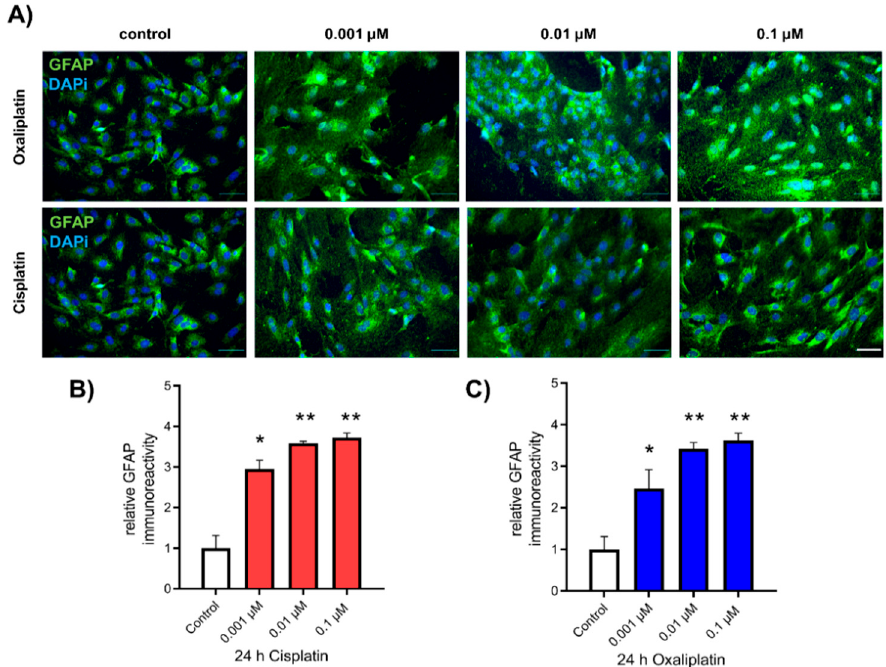
Figure 2. Expression of GFAP in cultures of spinal Astrocytes before and after exposure to cis- or oxaliplatin. ( A ) Immunocytochemical staining of GFAP (green) in cultured spinal astrocytes before and after exposure to 0.001 µM, 0.01 µM, or 0.1 µM cis- or oxaliplatin for 24 h. Nuclear DNA was stained with Dapi (blue). ( B, C ) Exposure to all concentrations of cis- or oxaliplatin leads to an increase of the GFAP expression in spinal astrocytes after 24 h (* p < 0.05; ** p < 0.01). * = significant difference to control. n = 9 individual experiments with >100 cells each. Scale 50 µm.